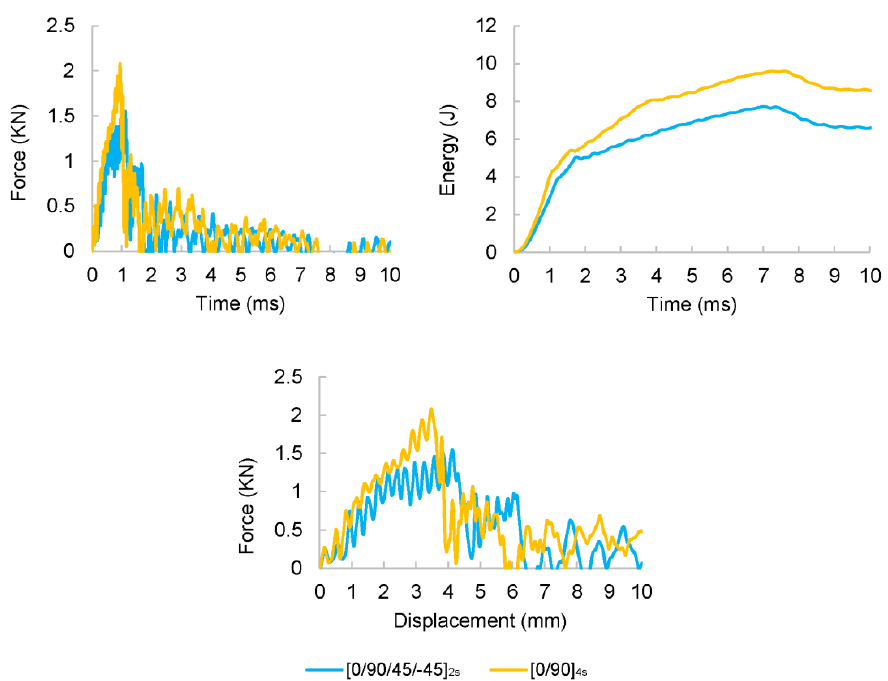
Figure 5. Average force and energy histories and force-displacement curves of non-thermal aged [0/90/±45] 2s laminates ( E impact = 32.46 J). Table 4. Maximum force and maximum impact strength results of non-aged laminates subjected to an impact energy of 32.46